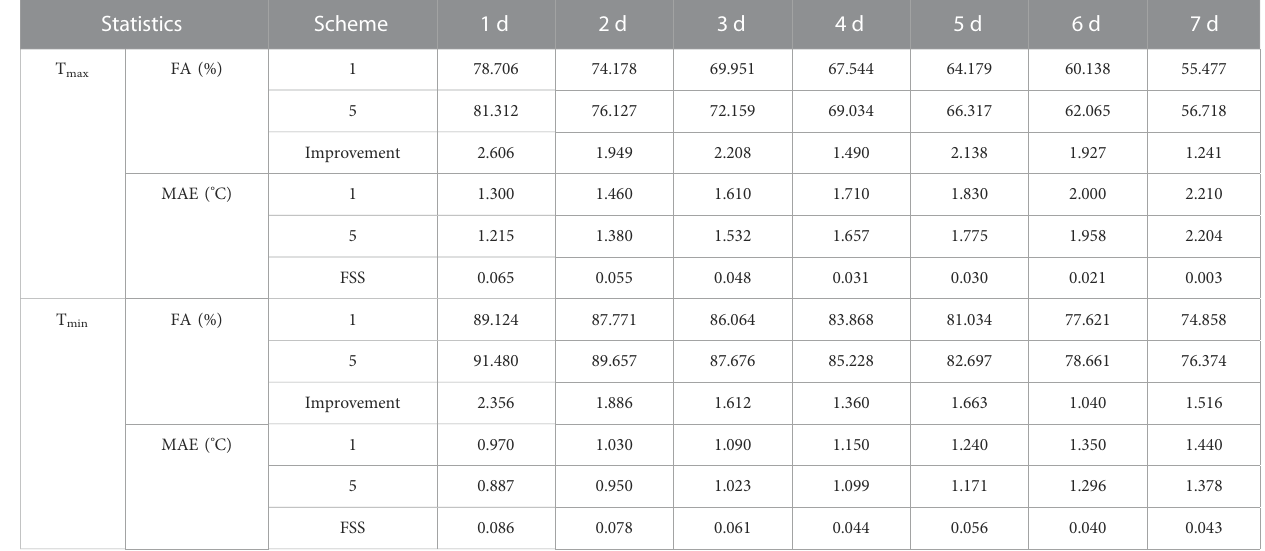
TABLE 1 Test results of T max and T min forecasts at 1 – 7 d by Scheme 1 and Scheme 5 in 2021.